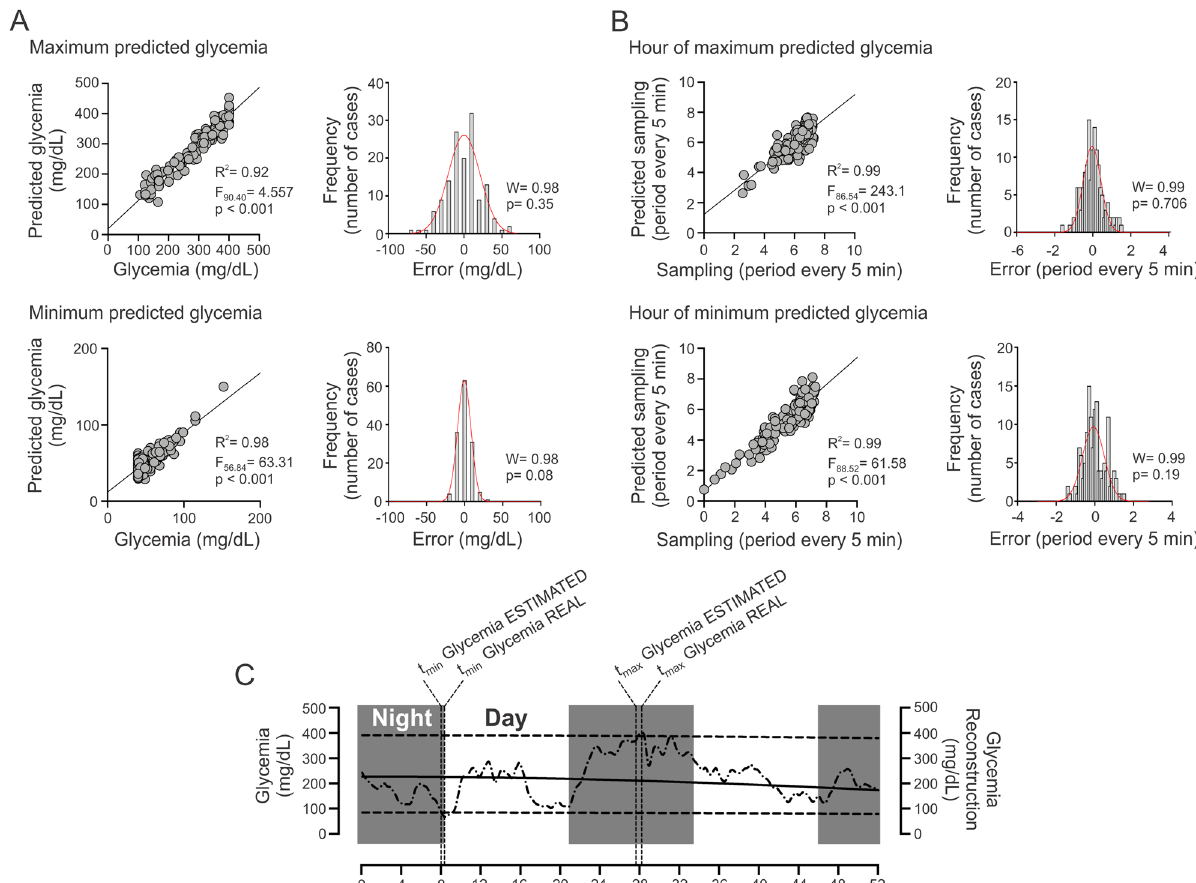
Figure 6. Predictive model of maximum and minimum glycemia and hour of maximum and minimum glycemia status in T1D patients. ( A ) (left panel) Scatterplot between real maximum glycemia and predicted maximum glycemia and between real minimum glycemia and predicted minimum glycemia. (right panel) Distribution of error of the model to maximum and minimum glycemia. The error was normal to maximum and minimum glycemia status. ( B ) (left panel) Hour of maximum and minimum predicted glycemia. (right panel) Distribution of error of the model to hour of maximum and minimum glycemia. The error was normal to both models. ( C ) Representative recoding of CGM and mean, minimum and maximum predicted glycemia of one DM patient. Horizontal segmented line represents minimum and maximum predicted glycemia. Vertical segmented line showed time of minimum (t min ) and maximum (t max ) real and predicted glycemia. Note that real and predicted glycemia are closely